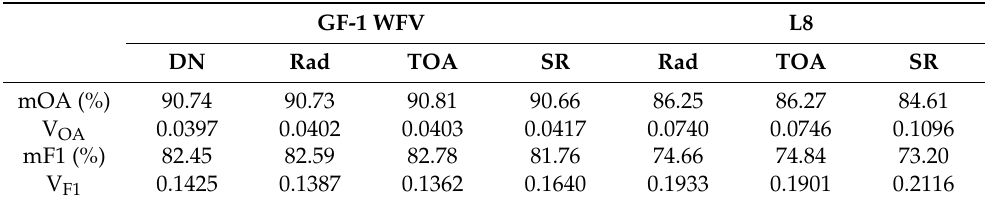
Table 4. Classification accuracy of GF-1 WFV and L8 at different processing levels. Both GF-1 WFV and L8 used B, G, R, and NIR